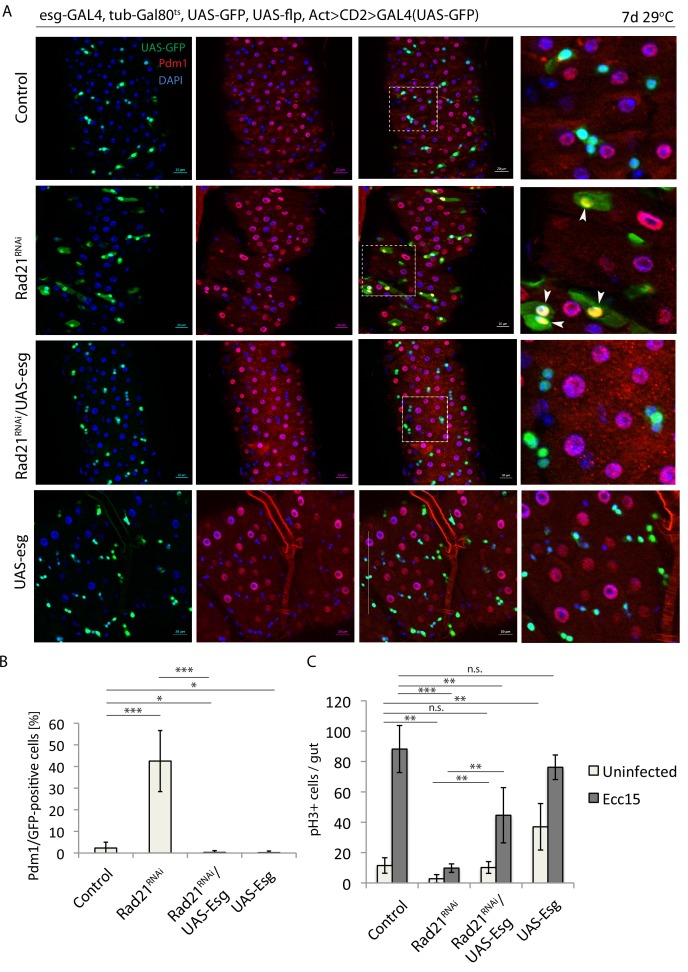
Escargot overexpression prevents Rad21 RNAi-induced ISC differentiation.(A) esg-F/O midguts expressing UAS-GFP alone (control), expressing rad21RNAi, UAS-esgRNAi/rad21RNAi or UAS-esg. Samples were stained for GFP and Pdm1. (B) Quantification of GFP-positive/Pdm1-positive cells from A. (n = 491, 402, 391, 766), (C) Quantification of the number of mitotic pH3-positive cells/midgut in esgts guts expressing UAS-GFP alone (control), rad21RNAi, UAS-esg/rad21RNAi or UAS-esg with and without Ecc15 infection (n = 4–6), ANOVA. *p<0.05, **p<0.01, ***p<0.001, n.s. not significant. Differentiated cells are labeled with white arrowheads. Scale bars, 20 µm.